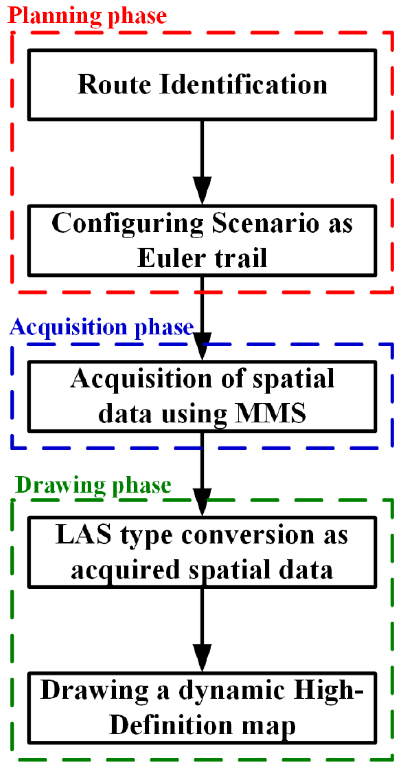
Figure 4. Flow chart of acquisition data using the MMS.